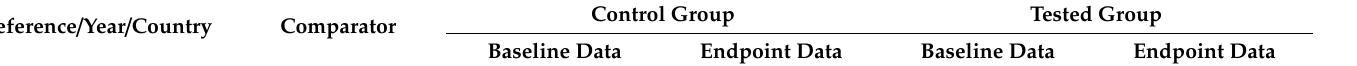
Table 2. Results of the systematic